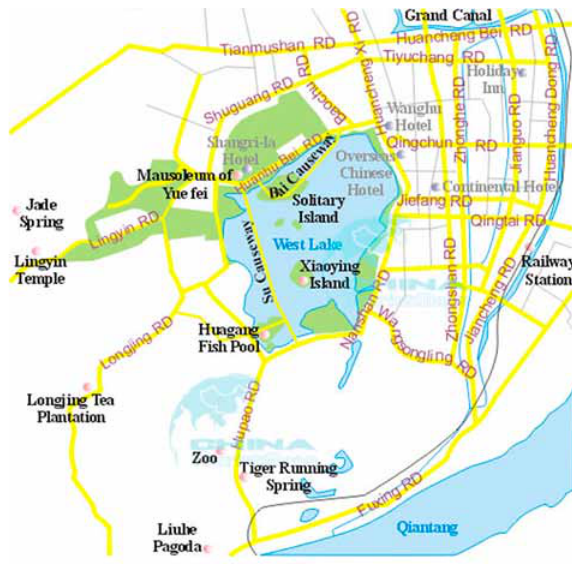
fig. 7. Map of West lake Scenic area in Hangzhou. It shows West lake as a scenic area that serves as a “stepping stone” to link up surrounding green spaces (China Tourist